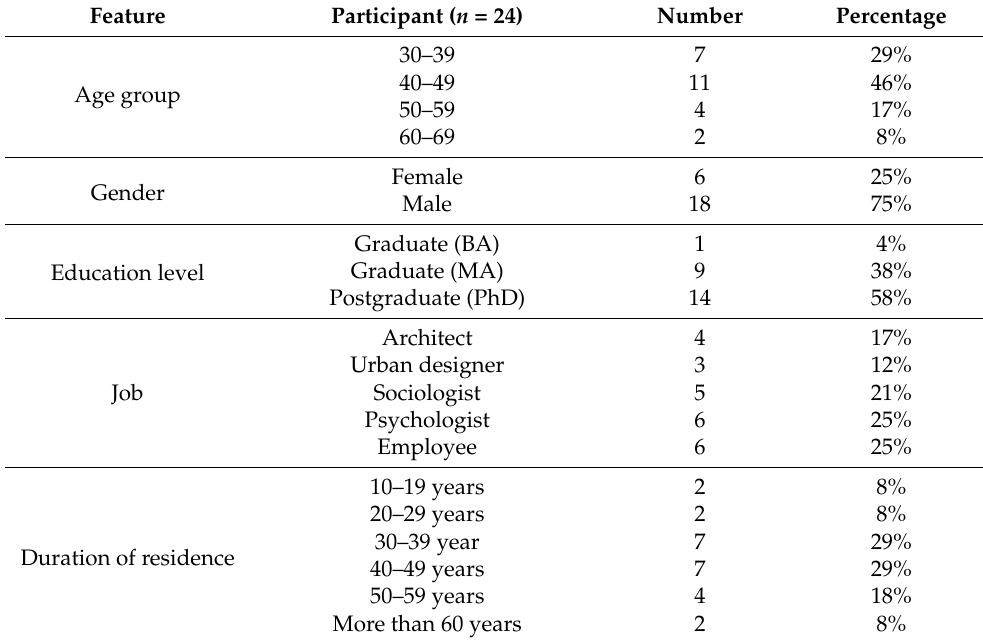
Table 1. The sociodemographic status of interview participants.